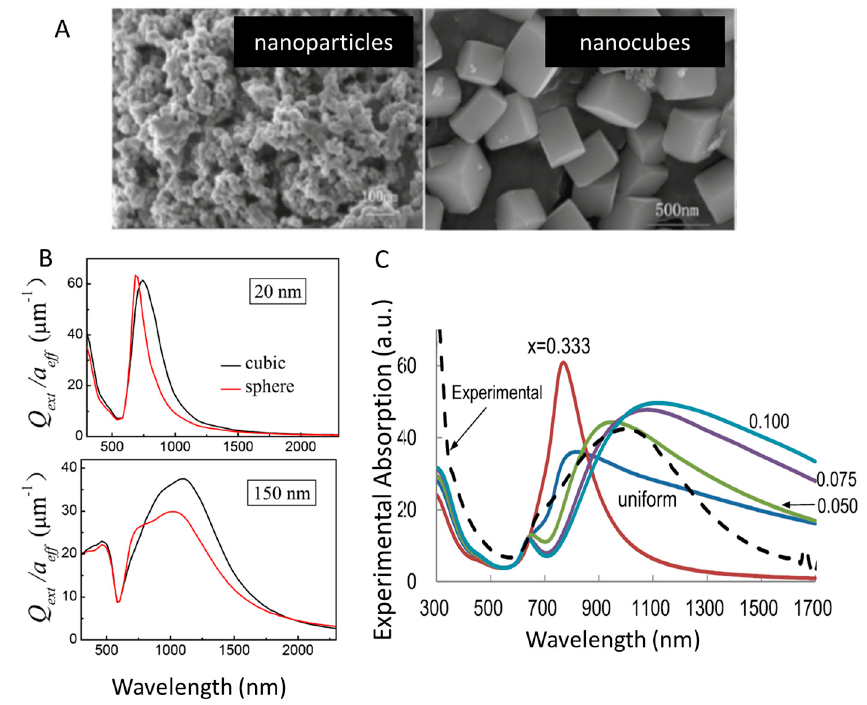
Figure 6. ( A ) SEM images of LaB 6 nanoparticles and nanocubes (reprinted from [57]). ( B ) Comparison of extinction efficiencies divided by effective radius between cubic and spherical LaB 6 particles (reprinted from [82]). ( C ) Absorption cross sections calculated for 100,000 LaB 6 oblate particles with different aspect ratios and a standard deviation of 0.1 (reprinted from